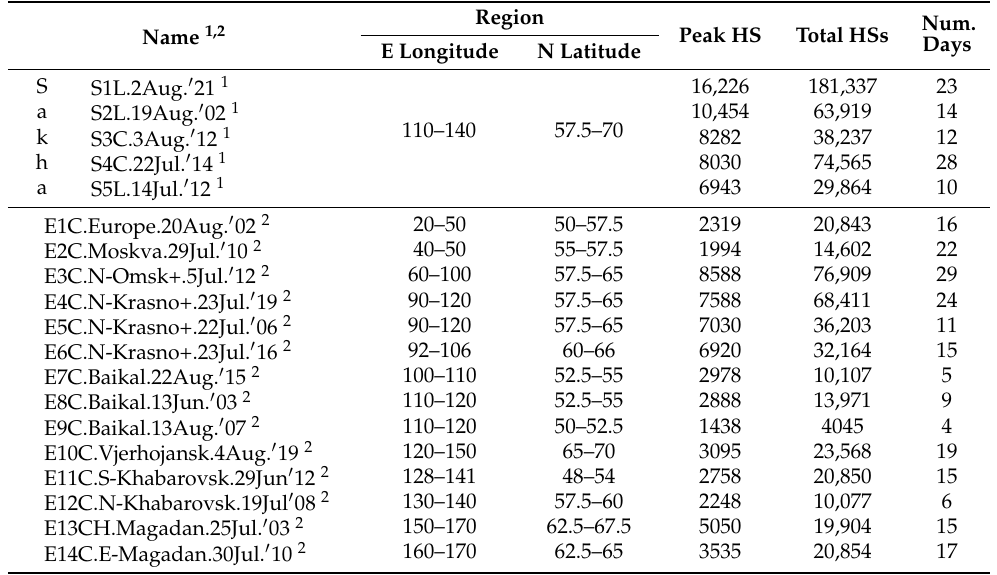
Table 1. Top five active fires in Sakha and other active fires in Eurasia. Name 1,2